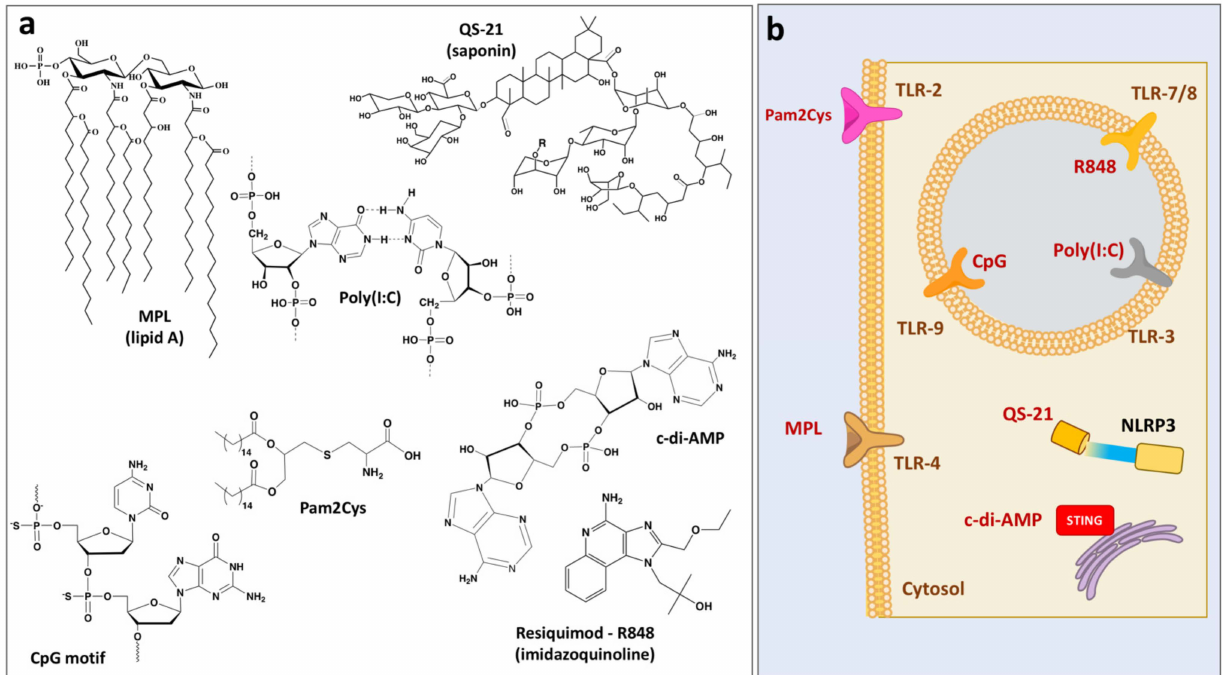
Figure 2. ( a ) Chemical structures of immunostimulating molecules and ( b ) their cellular